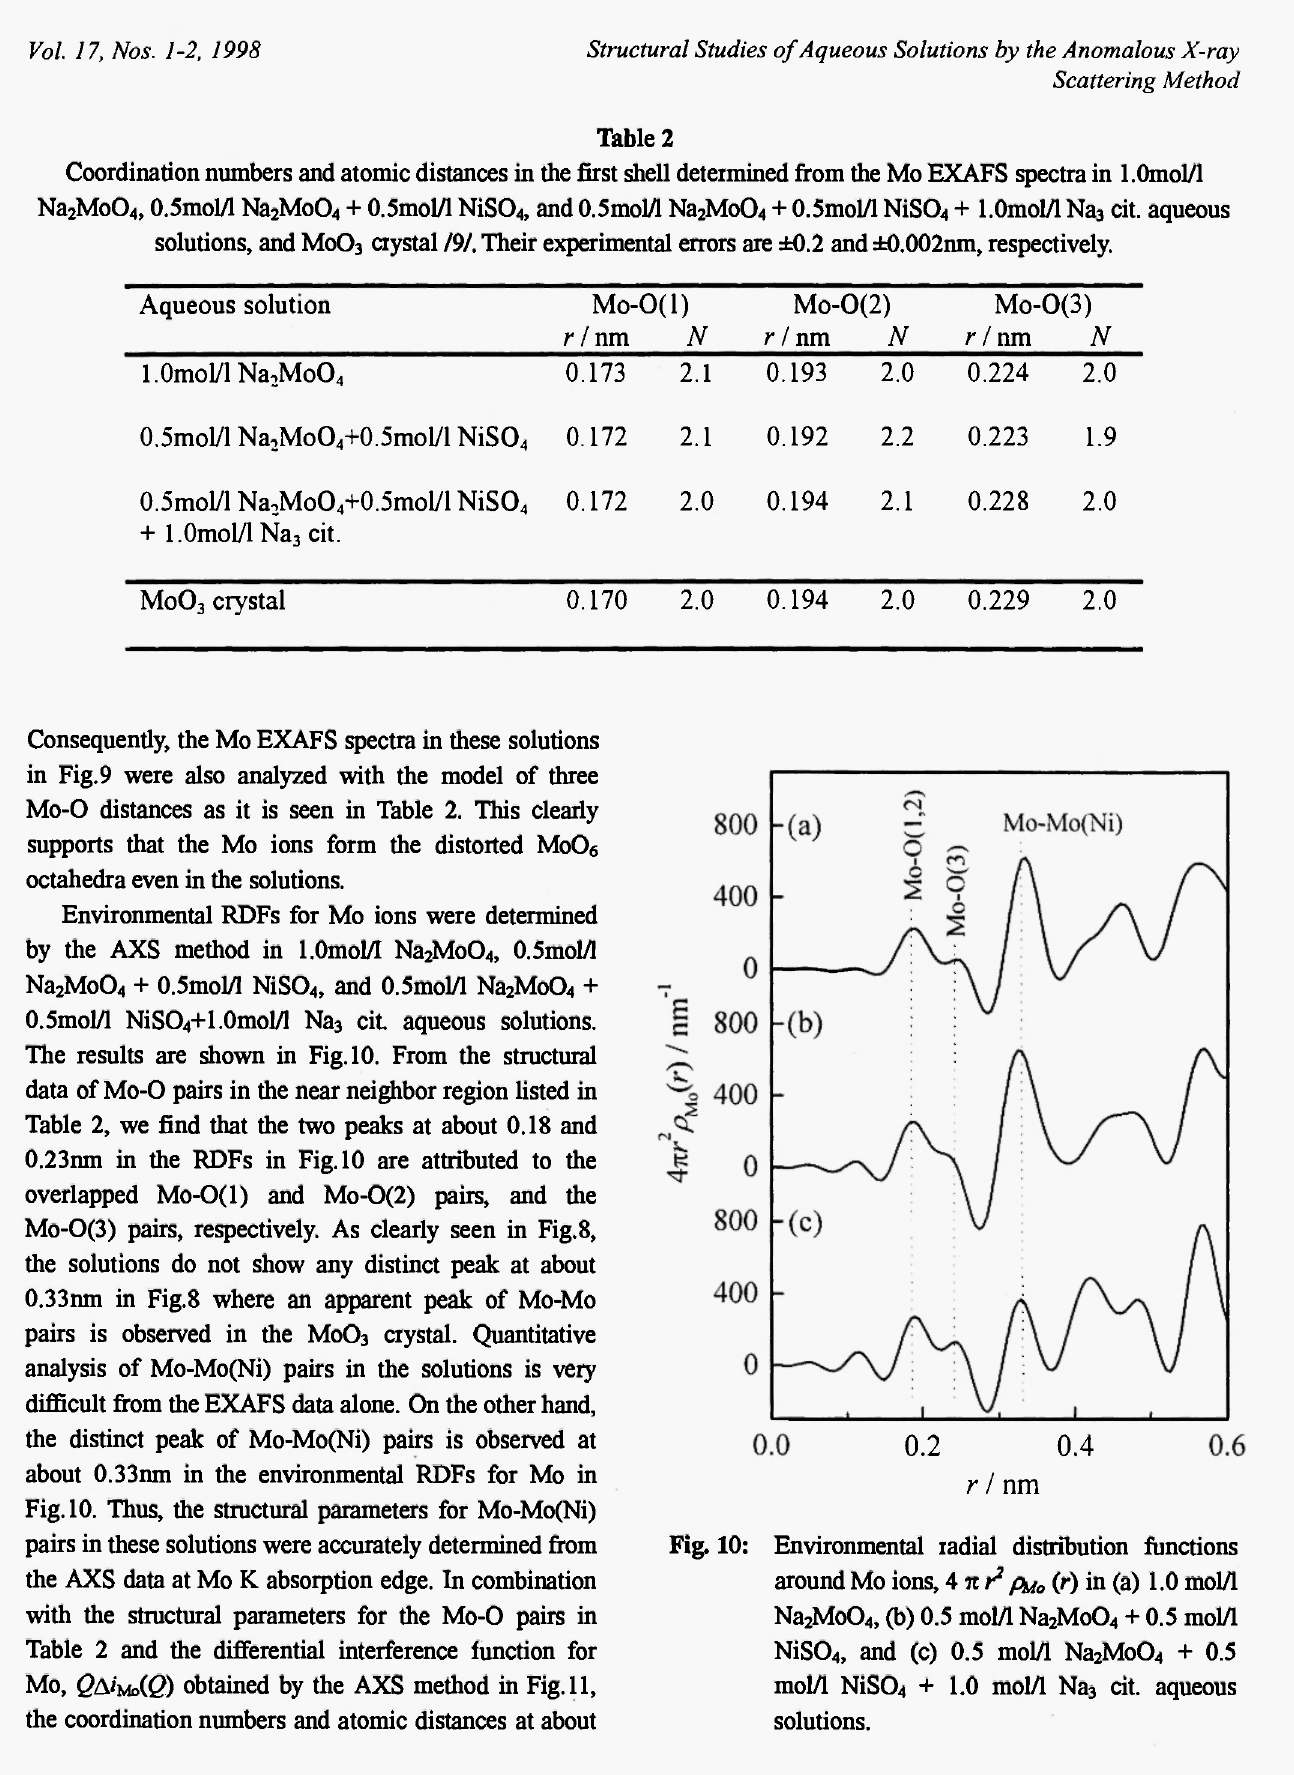
Fig. 10: Environmental radial distribution functions